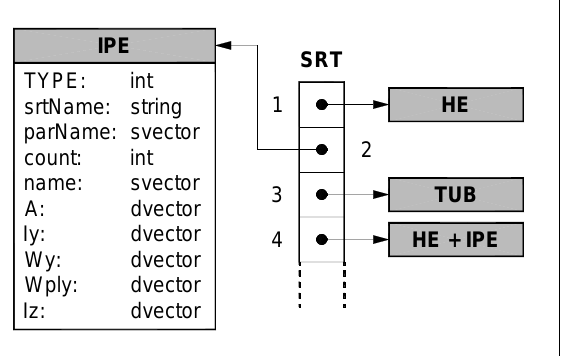
Fig. 16. The structure of steel profile